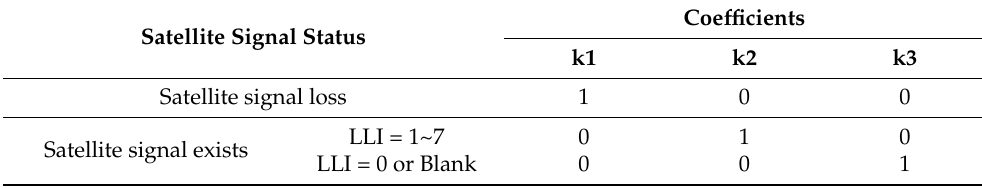
Table 1. The coefficients for PAS calculation.